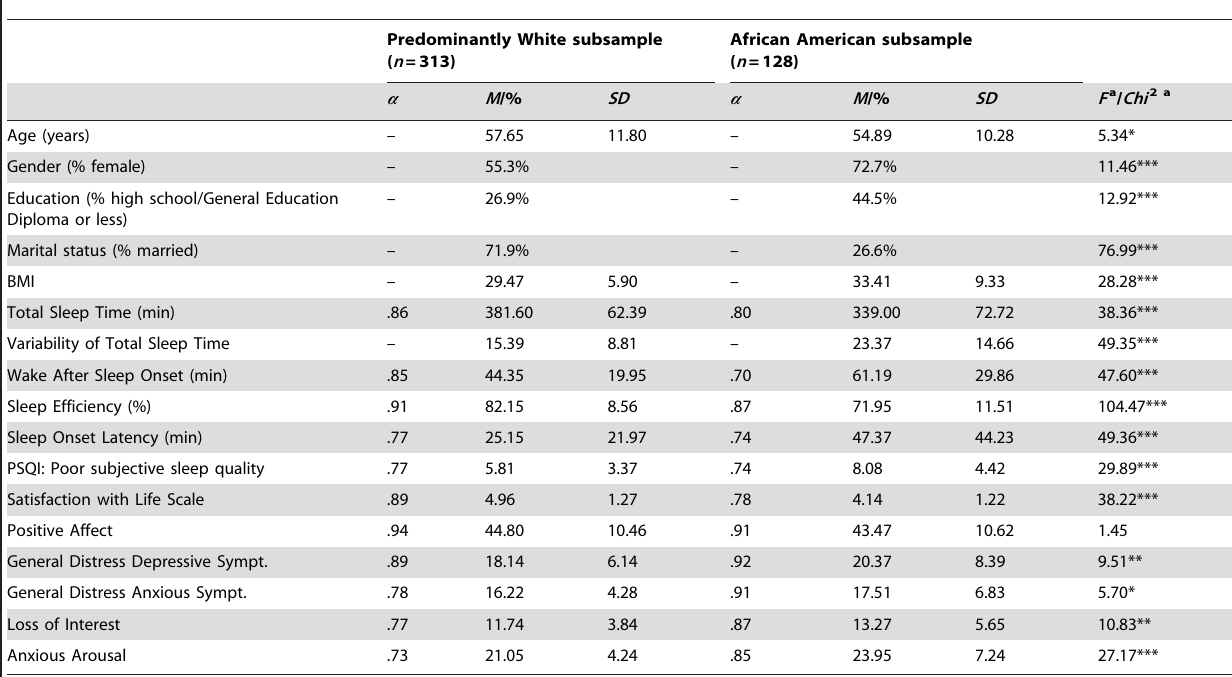
Table 1. Sample characteristics and reliabilities, means, and standard deviations of study variables in both